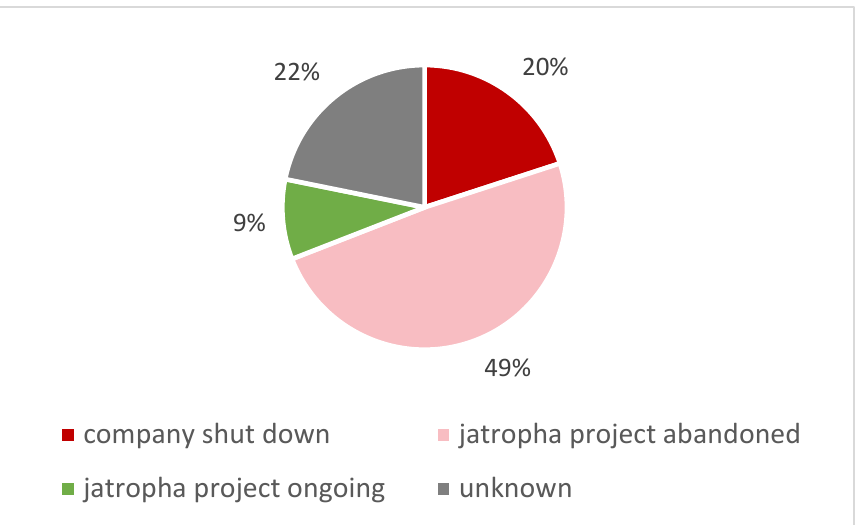
Figure 3. Companies that had jatropha projects in India by status in 2020; source: author survey. “ Several misunderstandings and half-truths came together in the case of jatropha. Claims made by Indian politicians that this miracle plant would bring income to the poorest on ‘marginal land’ were just idle talk. [ . . . ] I attended so-called ‘international’ biofuel conferences (international because there were one or two foreign guests, sometimes just me) in India myself from 2003 onwards and saw it ‘live’. We never planned to invest. If that is written somewhere, then someone has made it up. ” (interview with international SME A in April 2020, author’s own translation). In addition to the disappointing experiences with jatropha as a biofuel plant itself, issues arose around land. While initially, the ambitious jatropha plans by the Indian government created interest among international investors and lead to the assumption that “ in India, apparently, there is a lot of state land that is useless, that could be rededicated with agreements with the government ” (interview with TNC A in March 2020, author’s own translation), investors that were actually attracted soon realized that this was not the case. “ All companies that were active in jatropha went to African countries, where it is easier to get land from the government. The stories about big jatropha developments and land grabbing for jatropha in India were rumors. ” (interview with international SME B in November